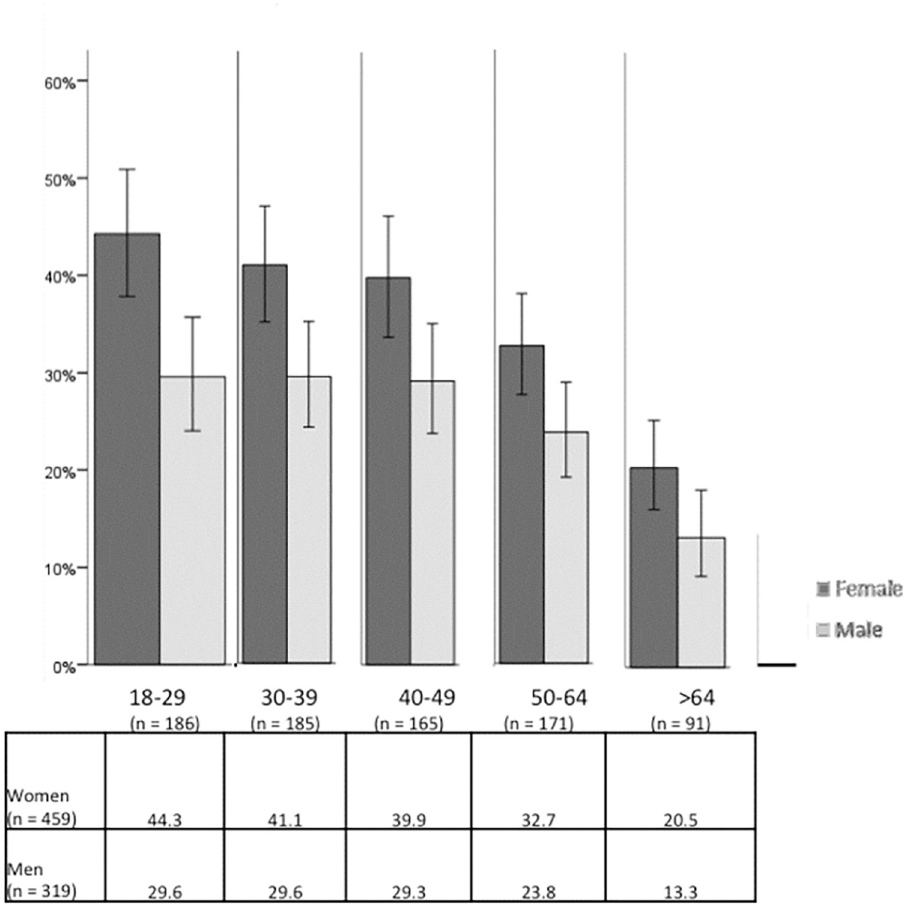
Fig 1. Percentage of people who know about a case of IPVAW occurring within their social circle, by sex and age. Source: Own elaboration based on CIS study 2968 [43], question 13. 95% confidence intervals are provided for each